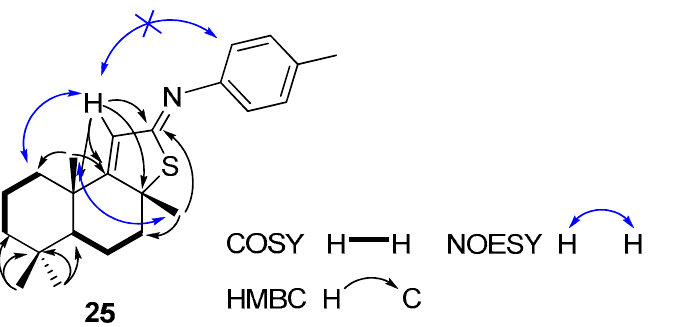
Figure 2. Selected COSY, HMBC, and NOESY correlations for compound 25 .